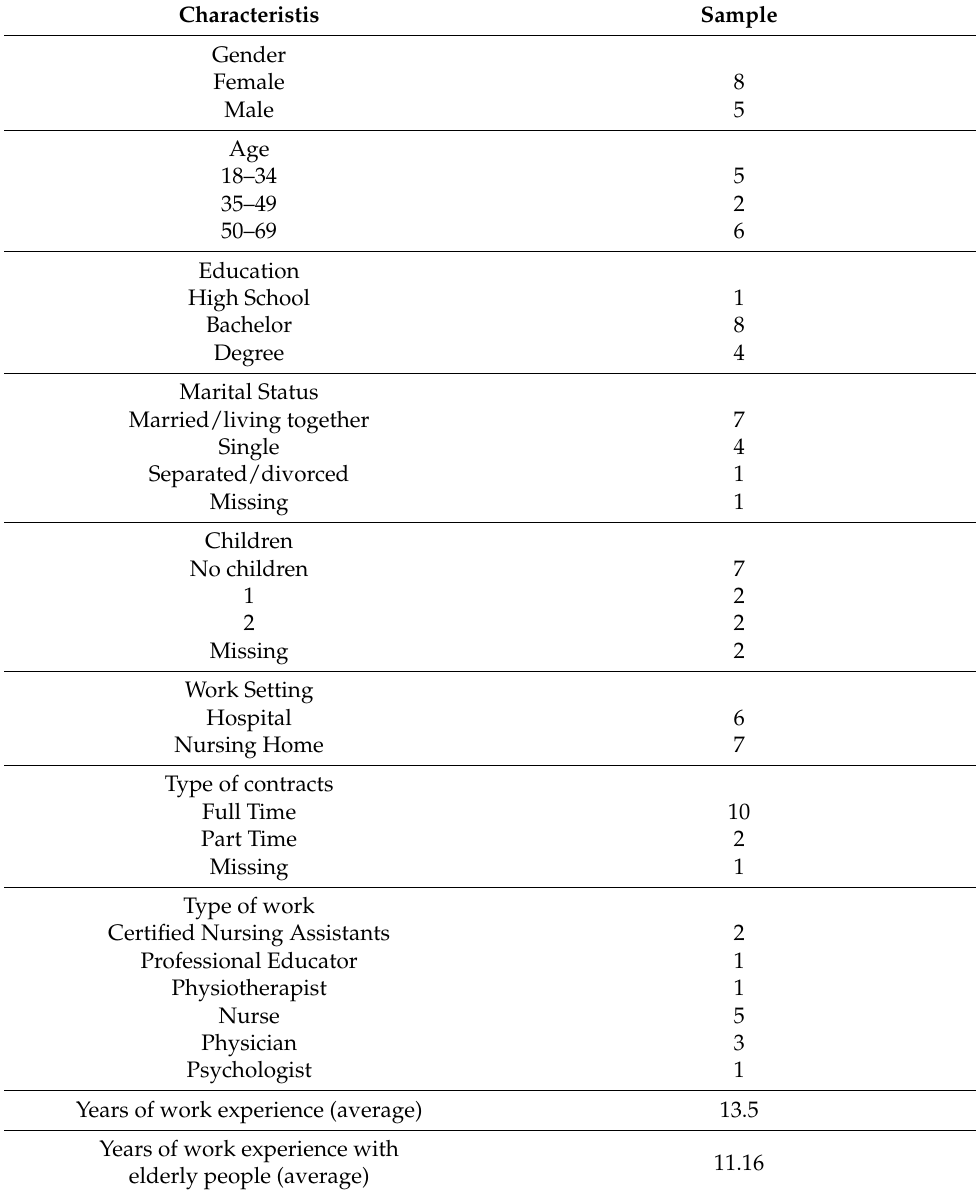
Table 1. Socio-demographic